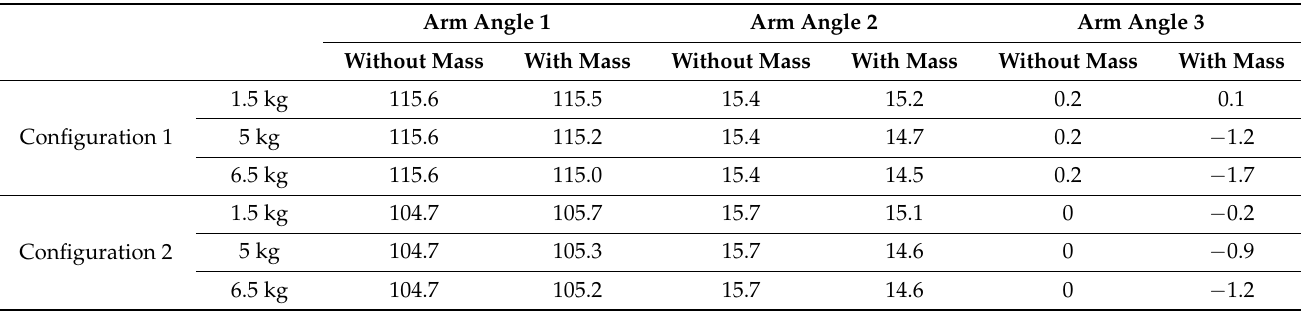
Figure 26. Vertical displacement variations for the 6.5 kg mass. The average values of the displace- ments were calculated in the time interval (0.48, 0.6) s. Table 3. Experimentally determined values of arm angles, for the five configurations, without a mass added to the effector and with a mass